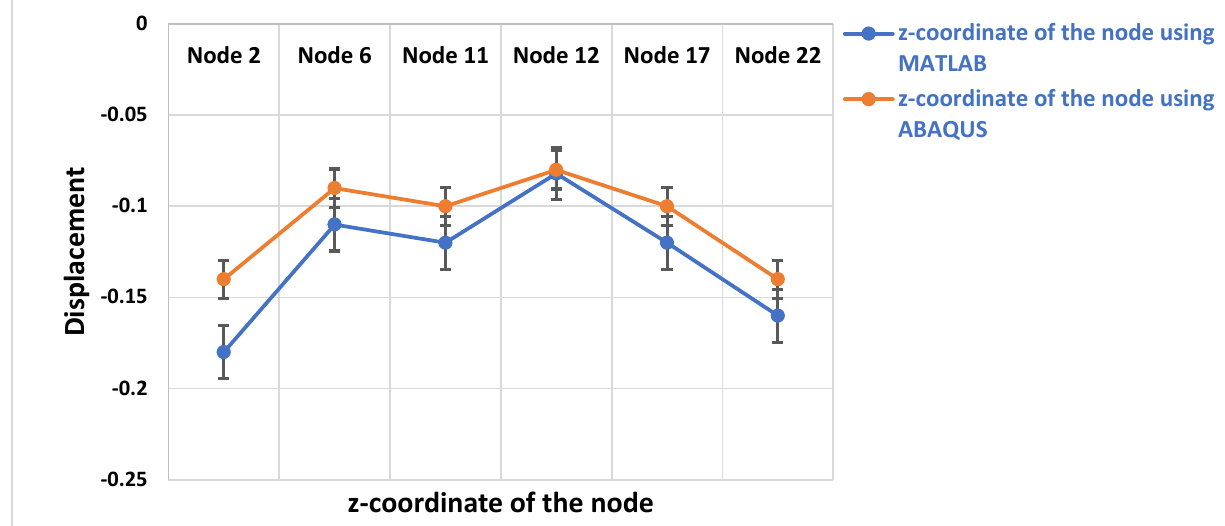
Figure 9. Comparison of the nodal displacements for the respective geometric position of z-coordinate using MATLAB and ABAQUS.